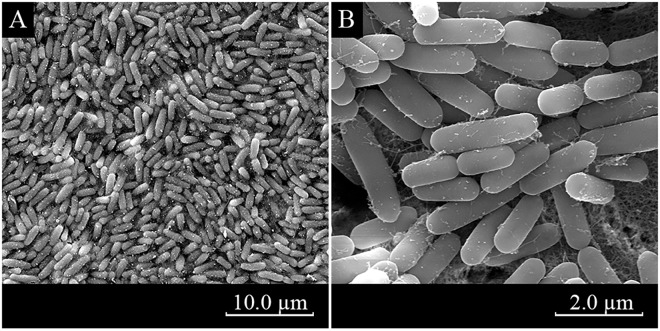
Scanning electron micrographs of B. methylotrophicus strain NKG-1.(A) Gram-positive staining of NKG-1; scale bar 10.0 μm; (B) Gram-positive staining of NKG-1, scale bar 2.0 μm.